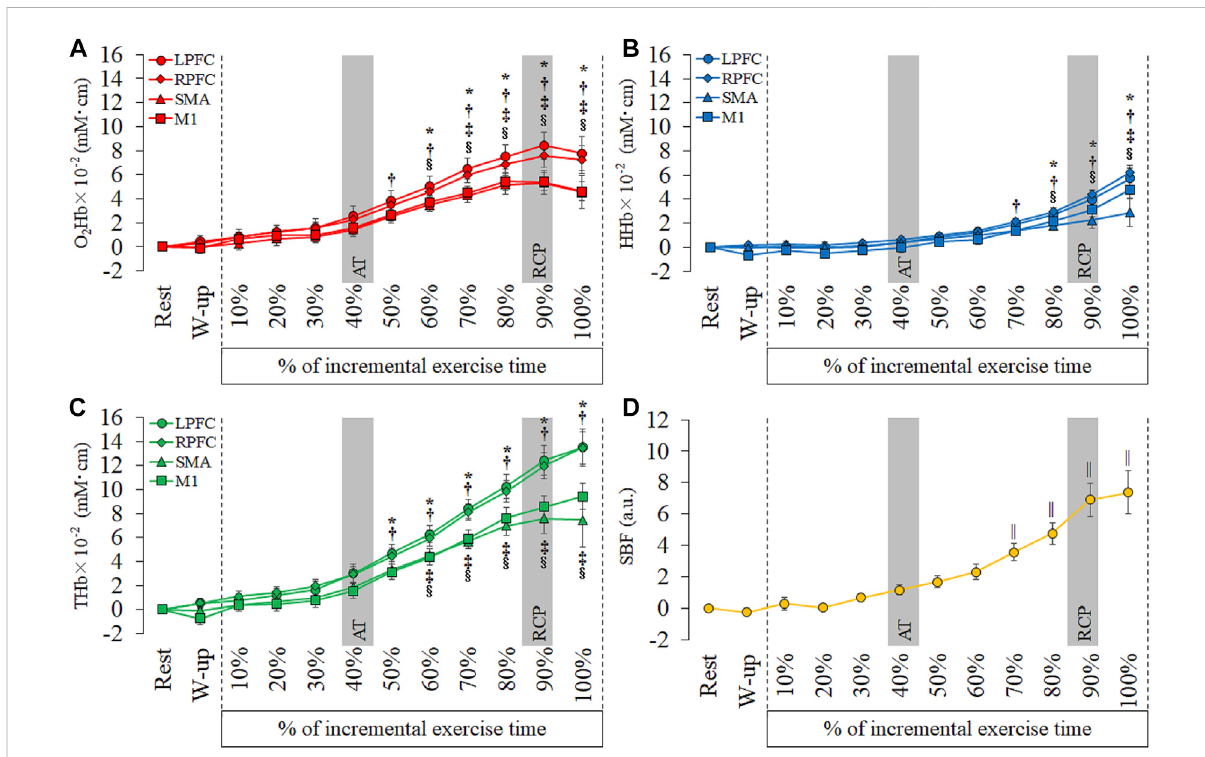
FIGURE 3 Temporal changes in each hemoglobin and skin blood fl ow (SBF) at each period of every 10 th of incremental exercise. (A) : oxyhemoglobin (O2Hb), (B) : deoxyhemoglobin (HHb), (C) : total hemoglobin (THb) and (D) : SBF. Region of interests are left prefrontal cortex (L-PFC), right prefrontal cortex (R-PFC), supplementary motor area (SMA) and primary motor cortex (M1). Gray bars show approximate position in the AT and RCP calculated from all participants. Signi fi cant different compared with rest: * p <